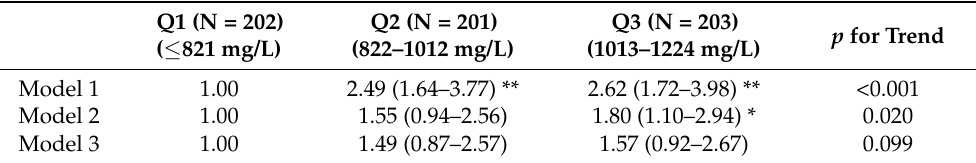
Table 3. Odds ratios of having NAFLD derived from multiple logistic regression analyses in tertiles of serum fetuin-A levels.